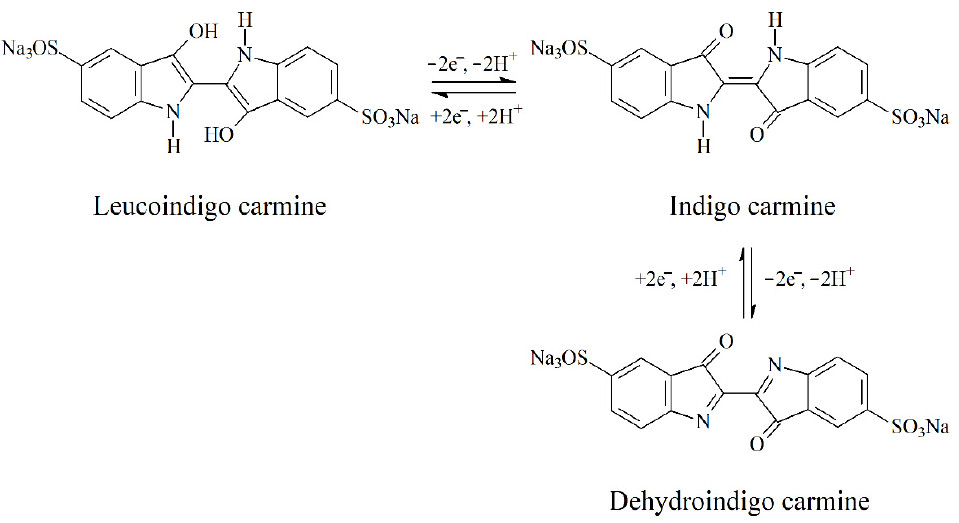
Figure 2. Redox behavior of indigo carmine.